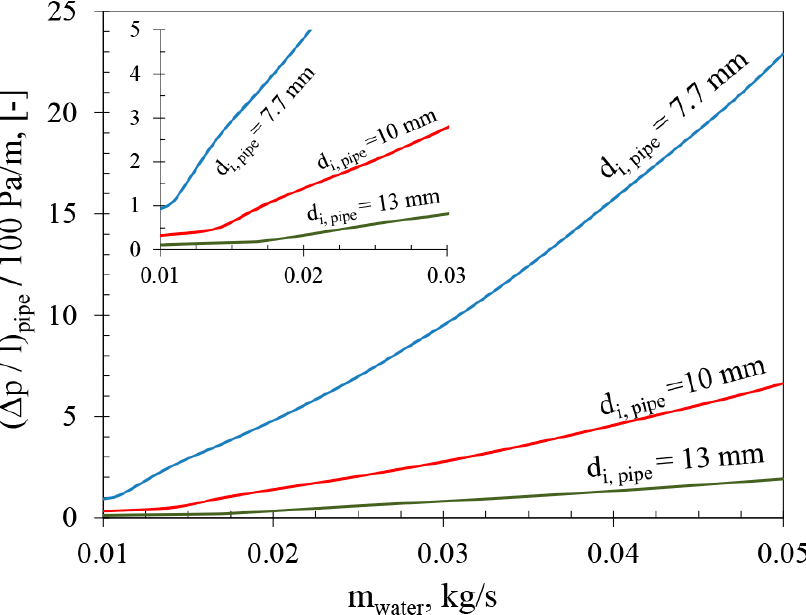
Figure 5. The increase of hydraulic pressure loss with increase of water mass flow rates for three pipe diameters usually used in floor and radiator heating systems.